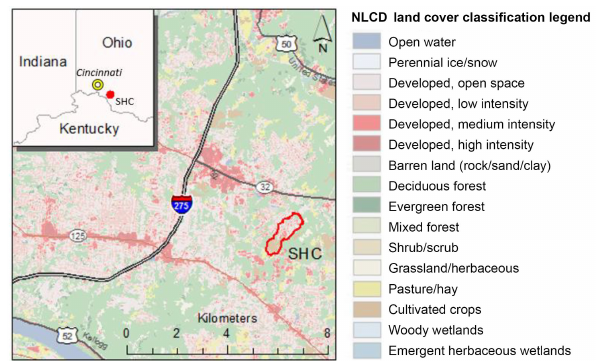
Figure 1. Location of the Shayler Crossing watershed. I-275 is an interstate highway around the Cincinnati metropolitan